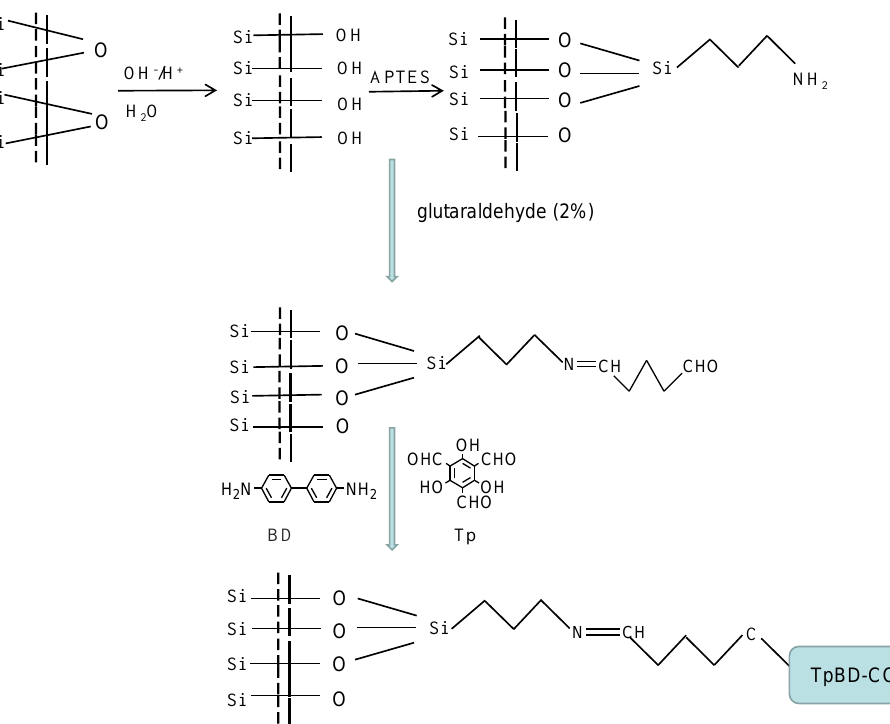
Figure 1. Preparation scheme for the TpBD COF immobilized capillary.